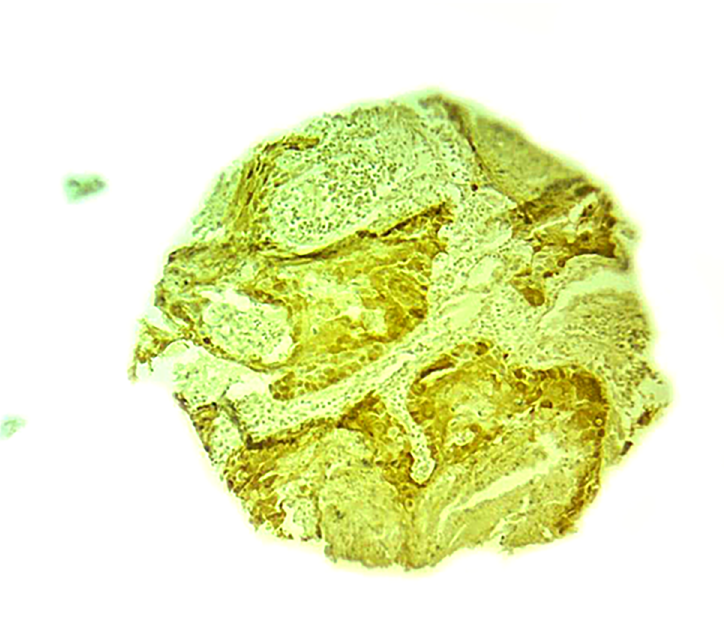
Fig 1. Microphotograph of the immunohistochemistry for p16 positive. Fig 1 shows microphotograph of the immunohistochemistry for positive expression of p16.